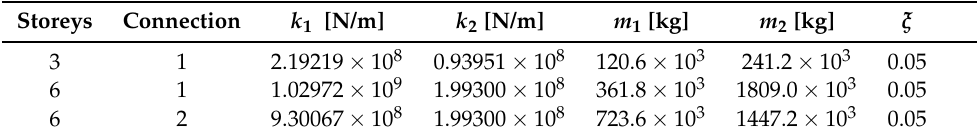
Table 2. Mechanical characteristics of the 2-DOF equivalent